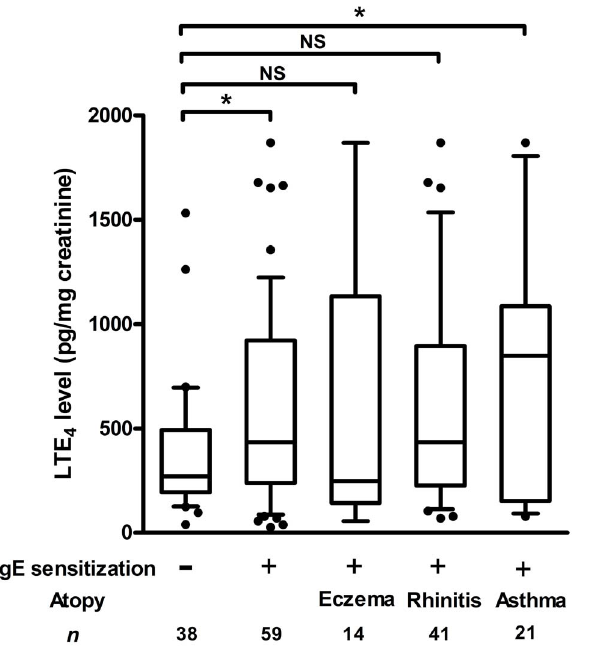
Fig. 4. Box plots showing median and interquartile ranges of urinary LTE 4 levels at age 4 by subject groups. Dots beyond the bounds of the whiskers denote outliers. P values refer to the comparisons indicated by the marker. * P , 0.05; NS, not statistically